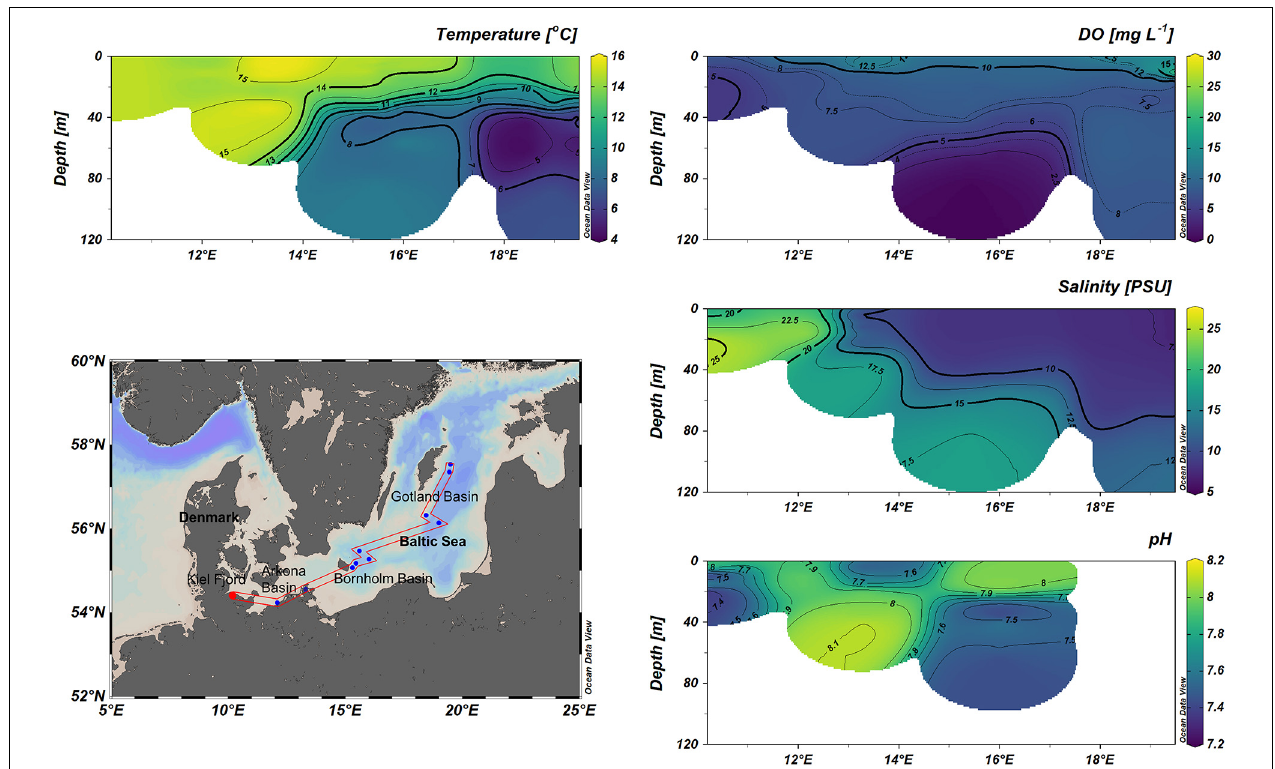
FIGURE 1 | Sampling distributions and vertical profiles of temperature, salinity, pH, and concentrations of dissolved oxygen in the Baltic Sea.